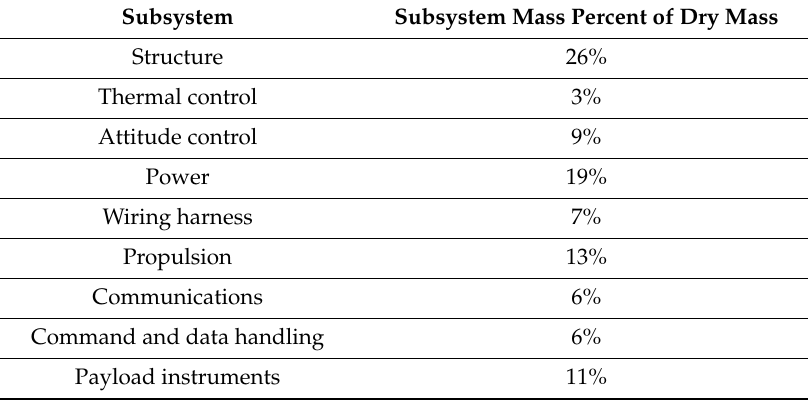
Table 2. Approximate dry mass fractions for each spacecraft